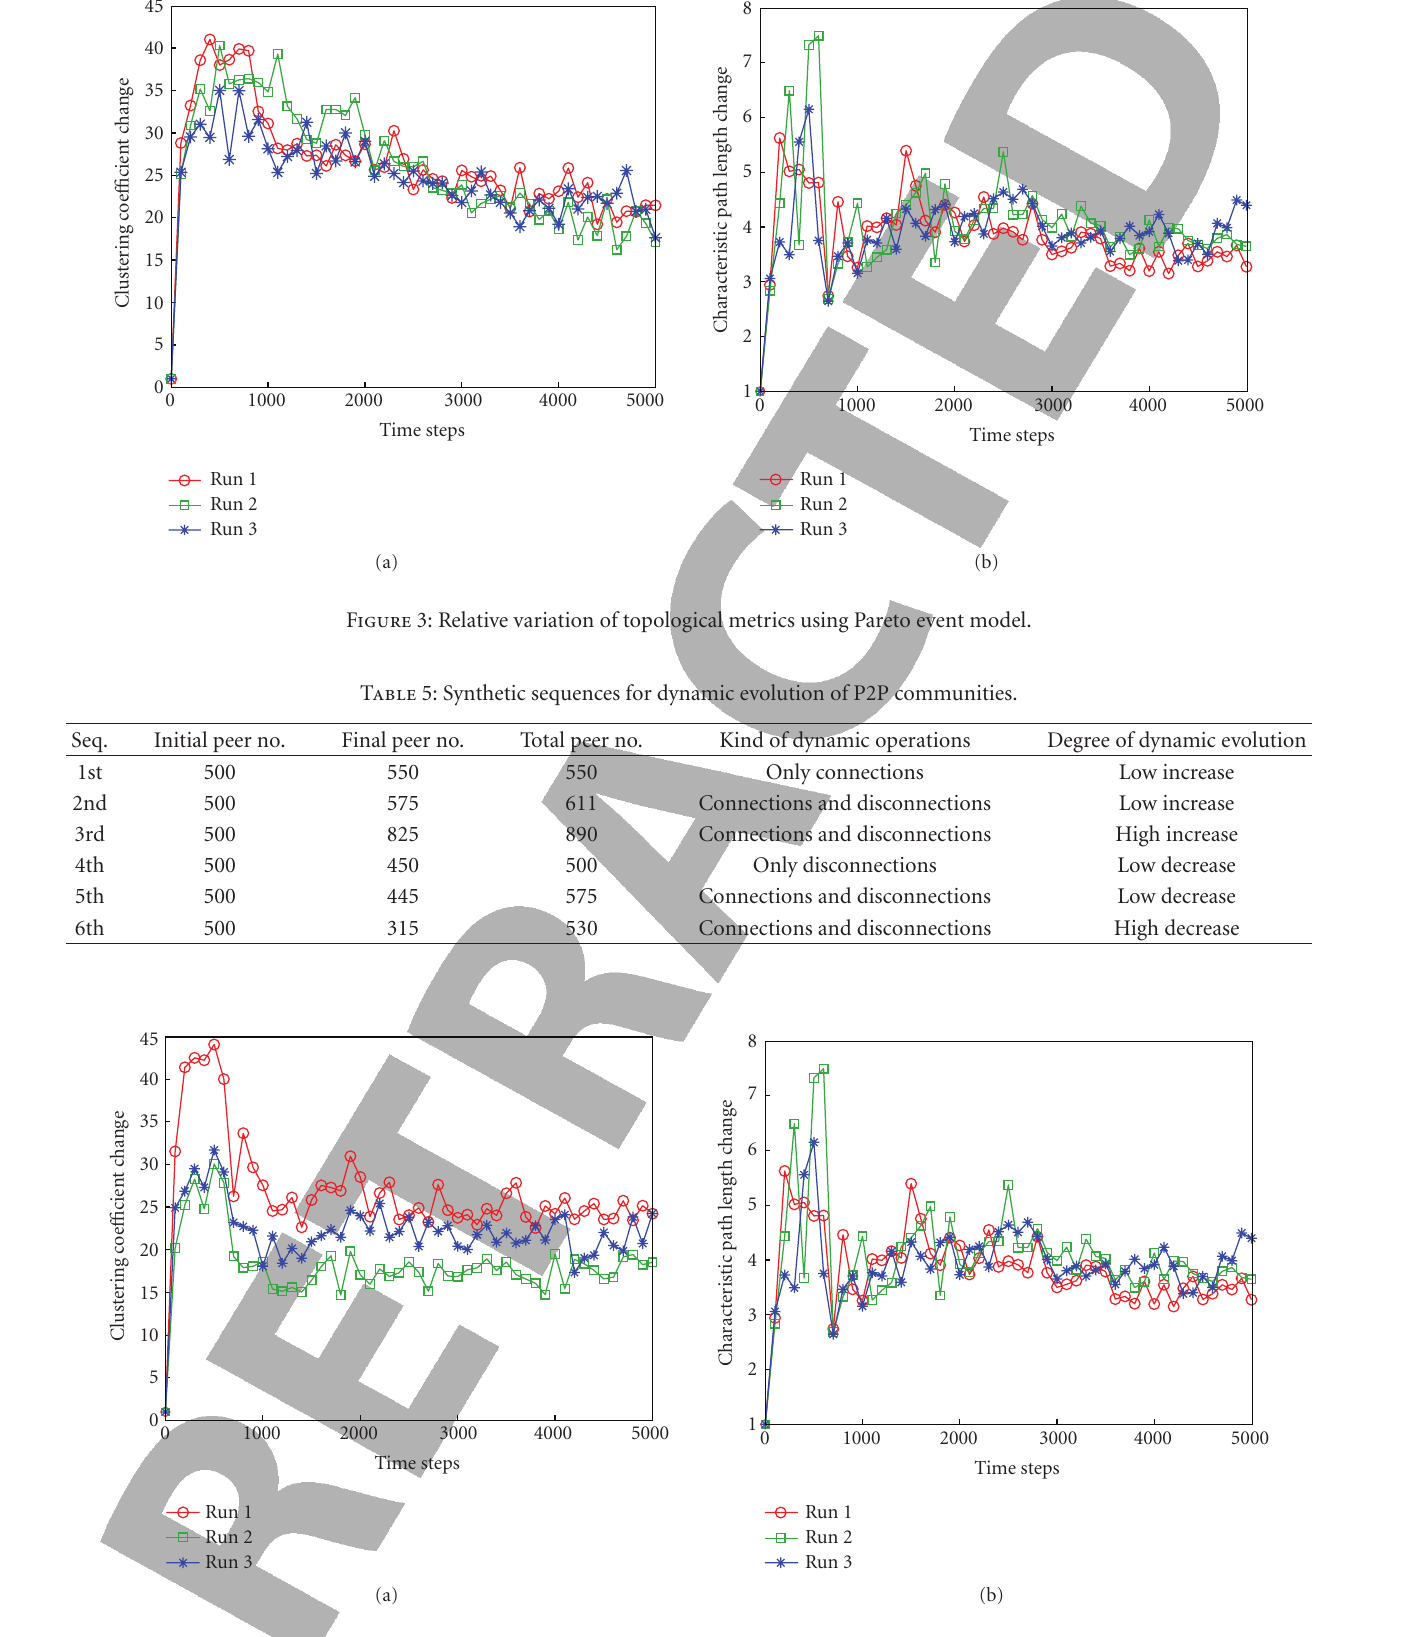
Figure 4: Relative variation of topological metrics using the 3rd sequence of